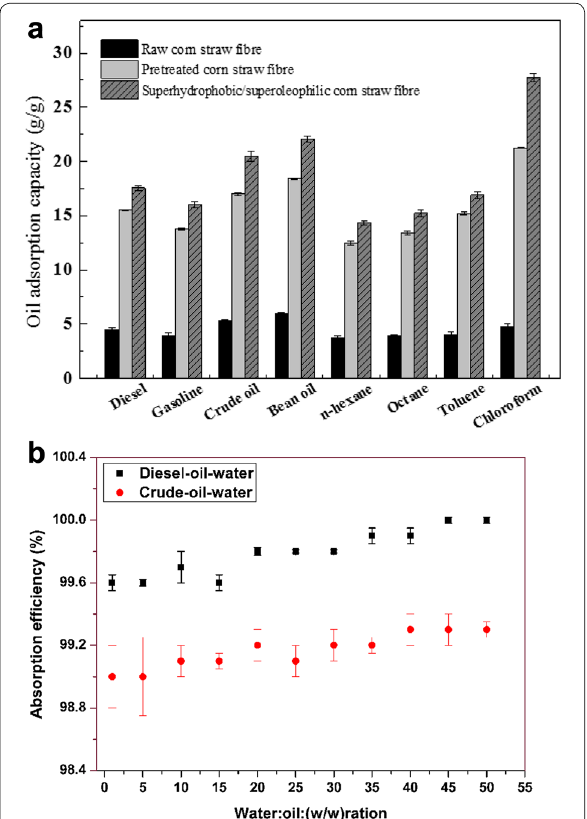
Fig. 8 a The absorption capacities of raw corn straw fiber,